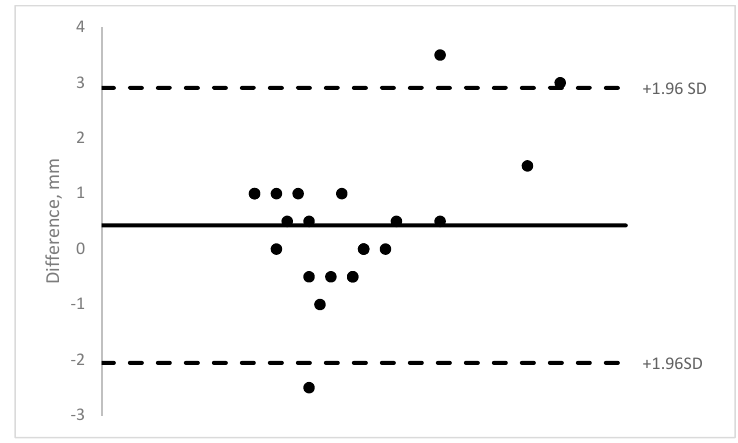
Figure 3. Bioptigen Bland–Altman plot of intra-operative measurements versus OCT measurement.